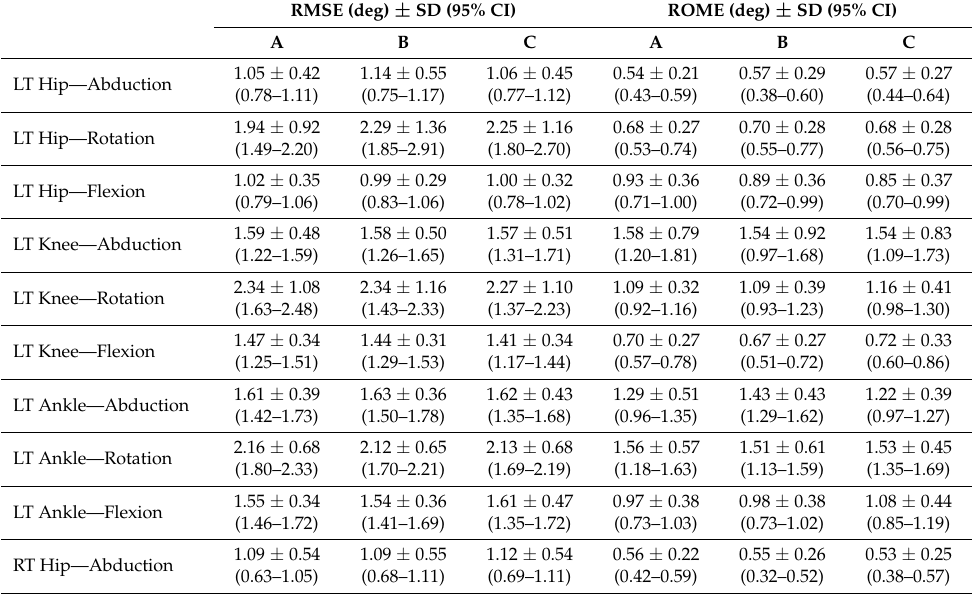
Table 1. Mean root mean squared error (RMSE) and mean range of motion error (ROME) of condition 1 over all subjects ± standard deviation (SD); brackets contain 95% confidence interval (CI). A, B, C indicate beginning, middle, and end of the 6 min walk